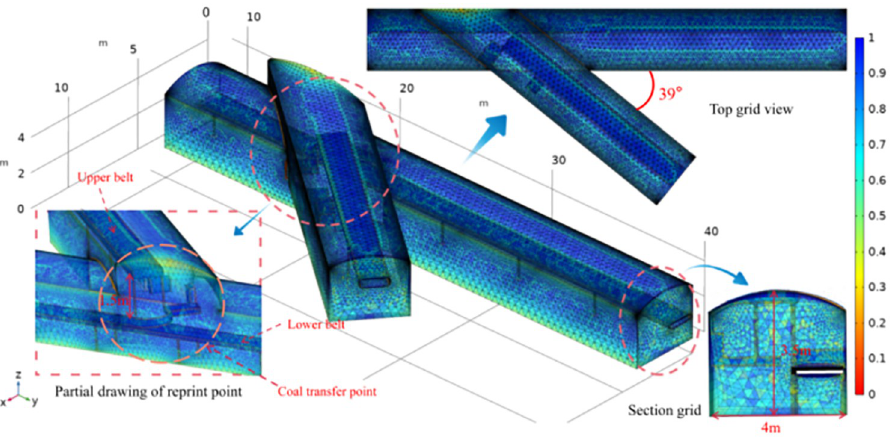
Fig 2. Reprint point model grid